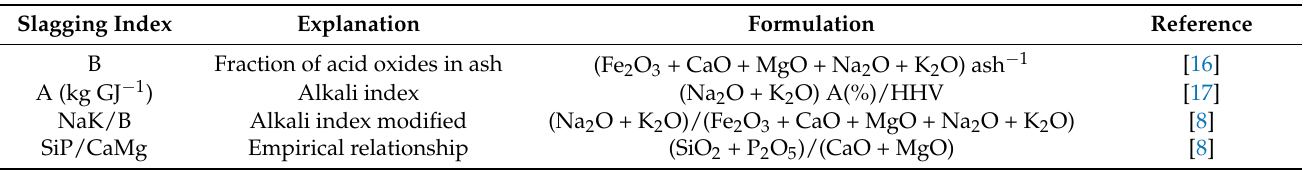
Table 2. Slagging indices calculated on the basis of ash composition at 550 ◦